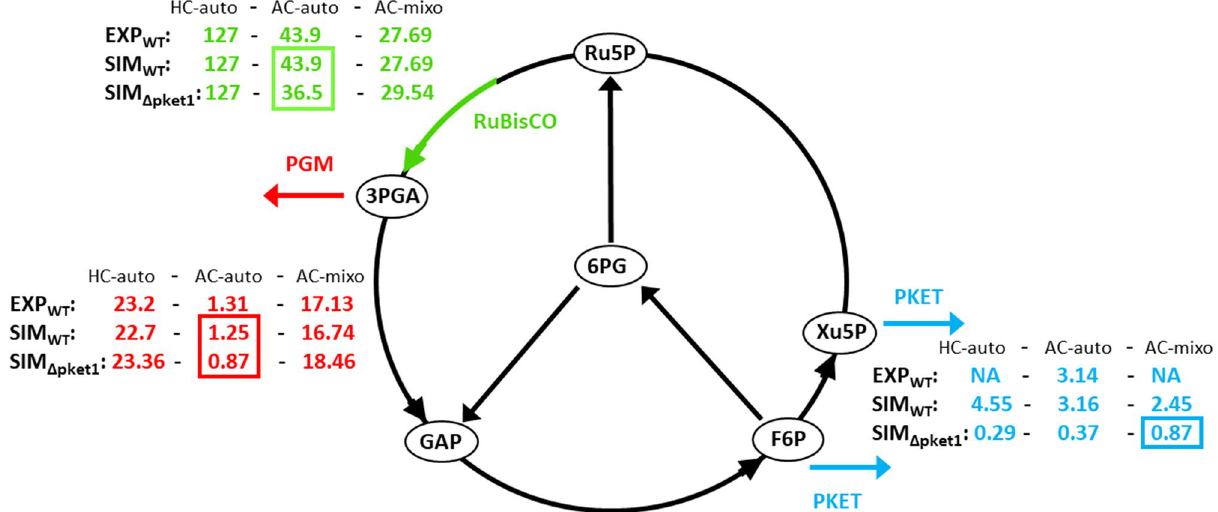
Figure 4. Experimental and estimated flux distribution in various environmental conditions. Green color indicates the flux via RuBisCO, blue color shows the flux via PKET (phosphoketolase) and red color highlights the flux via PGM (phosphoglycerate mutase). EXP WT and SIM WT indicates the experimental and simulated wild type values, respectively. SIM ΔPKET1 shows the results for silenced pket1 , while PKET2 remains active. Marked values indicates interesting values or their significant changes. Sources of experimental fluxomic data: HC-auto 14 , AC-auto 7 and AC-mixo 18 .